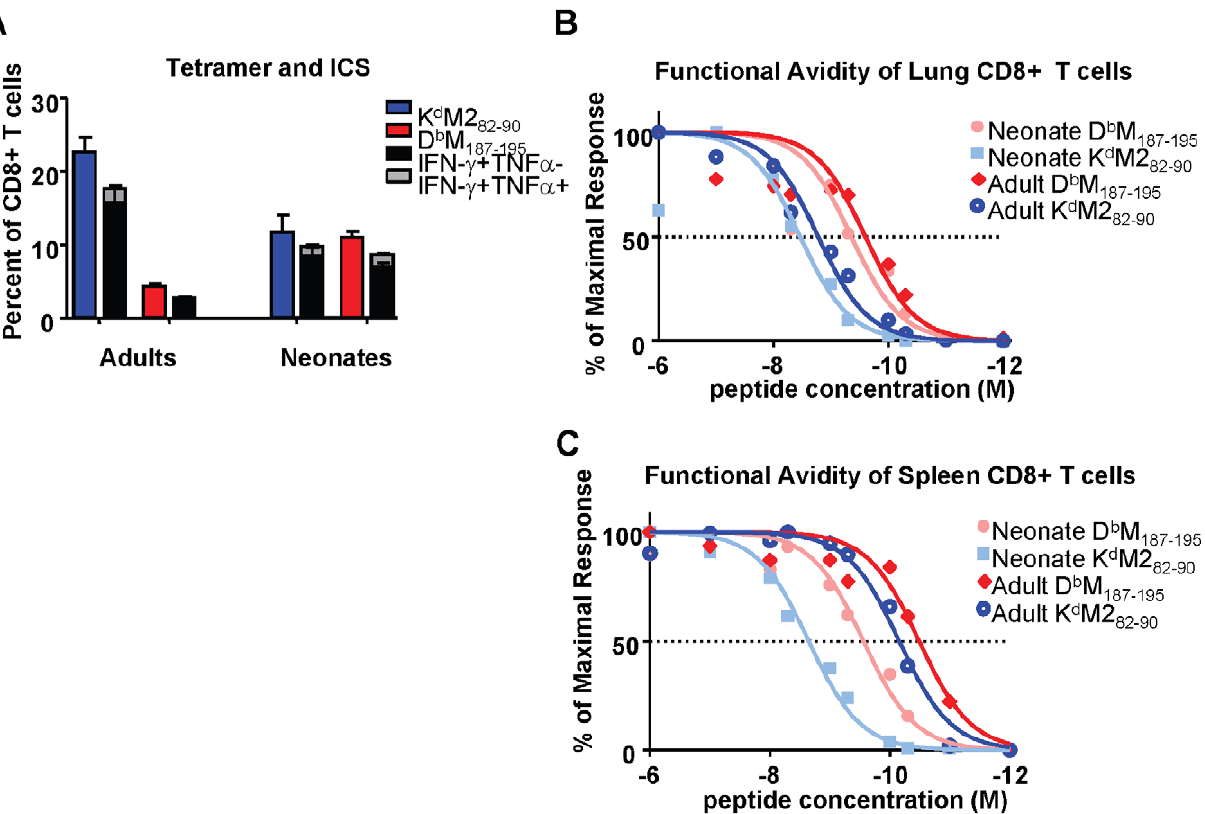
Figure 3. Epitope-specific CD8 + T cell cytokine production and functional avidities in RSV-infected adult and neonatal mice. (A) Frequency and cytokine production by CD8 + T cells specific for K d M2 82-90 and D b M 187-195 in the lungs of RSV-infected adults and neonates. Parallel samples were stained with tetramer and incubated with the M2 82-90 or M 187-195 peptide for 5 hours in the presence of the transport inhibitor monensin to measure intracellular cytokine staining by flow cytometry. Tetramer frequencies are indicated by the blue and red bars for the K d M2 82-90 and D b M 187-195 CD8 + T cell populations, respectively. (B) Functional avidities of K d M2 82-90 and D b M 187-195 –specific IFN- c -producing CD8 + T cells in the lungs of infected adults and neonates. All data were normalized to 100% production at 10 2 6 M of each peptide. (C) Functional avidities of K d M2 82-90 and D b M 187-195 specific IFN- c -producing CD8 + T cells in the spleens of infected adults and neonates. Data represent results from 3-4 independent experiments with 4-7 mice/group. Error bars represent the